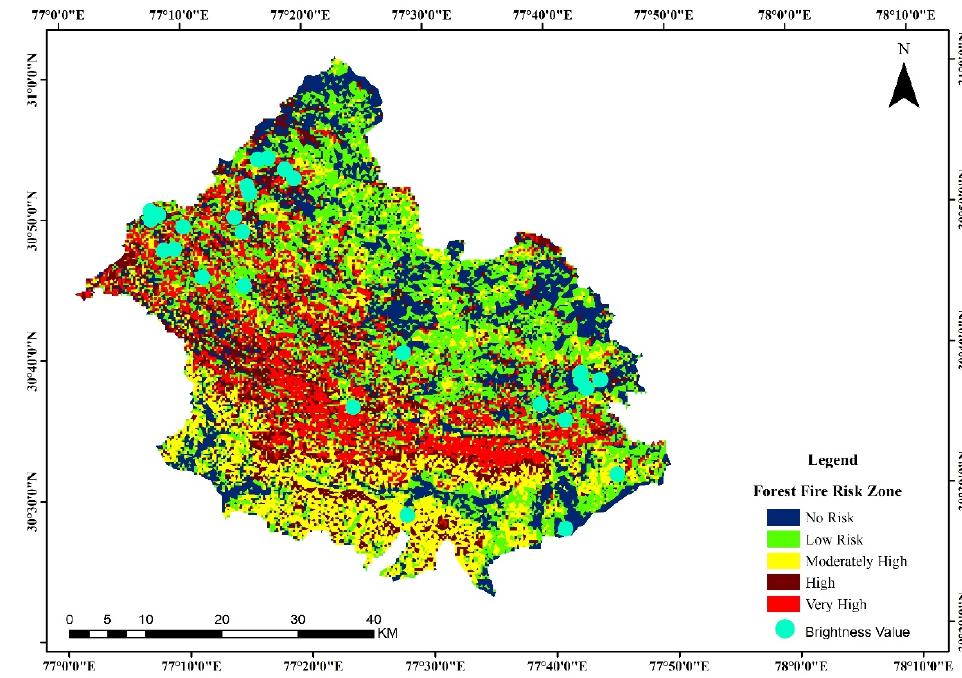
Figure 15. Forest fire validation hotspots in forest fire risk zone map .